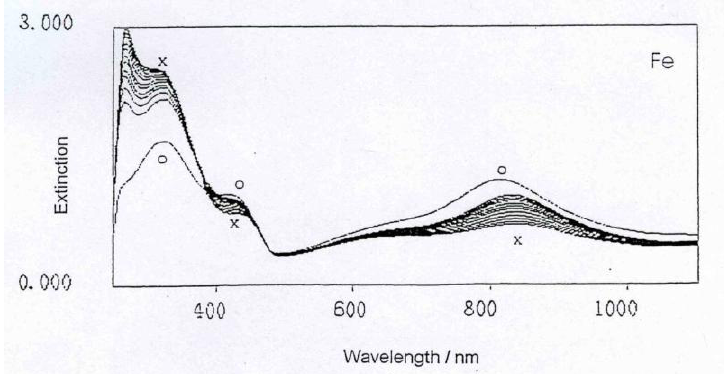
Figure 3. UV-Vis spectrum evolving during the reaction of polyaniline with Fe metal.